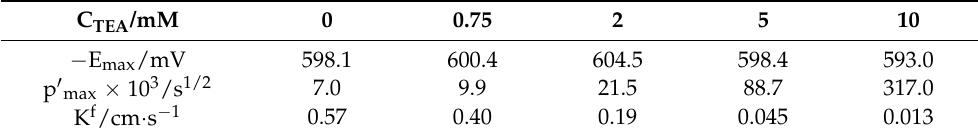
Table 3. Different parameter values from the plots p (cid:48) − E, and in the maximum (max).